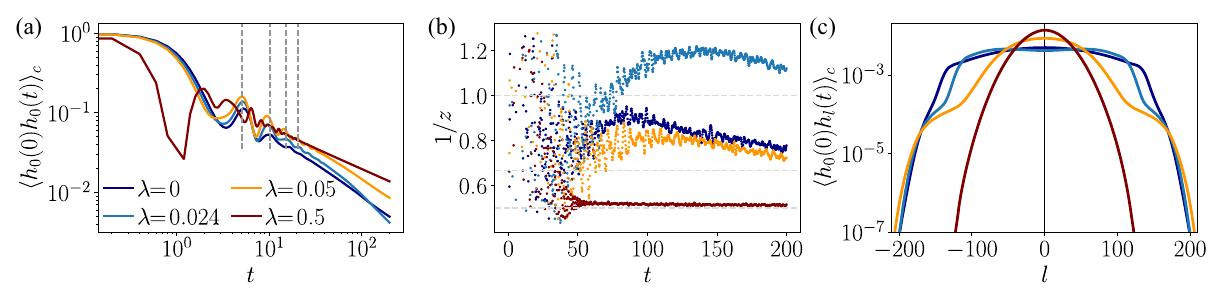
FIG. 4. (a) Connected energy autocorrelation function for several strengths λ of the PXPZ deformation. Early time oscillations approximately peak at times t ∈ f 5 . 1 ; 10 . 2 ; 15 . 3 ; 20 . 4 g (dashed lines) for the su(2)-enhancing perturbation λ ¼ 0 . 05 , note that the times correspond to the peaks observed in Figs. 1 and 2. (b) Long time decay is fastest for λ ¼ 0 . 024 , as manifested by the inverse dynamical exponent approaching the value of 1 from above. In contrast, large λ ¼ 0 . 5 results in a rapid onset of diffusive dynamics. (c) Spatial dependence of the connected energy correlation function at t ¼ 200 in the PXP model with the PXPZ deformation. In the vicinity of λ ≈ 0 . 024 , the profile becomes visibly flat, which is typical of ballistic transport. The data are for N ¼ 768 and bond dimensions χ ¼ 384 [panels (a),(b)] and χ ¼ 256 in